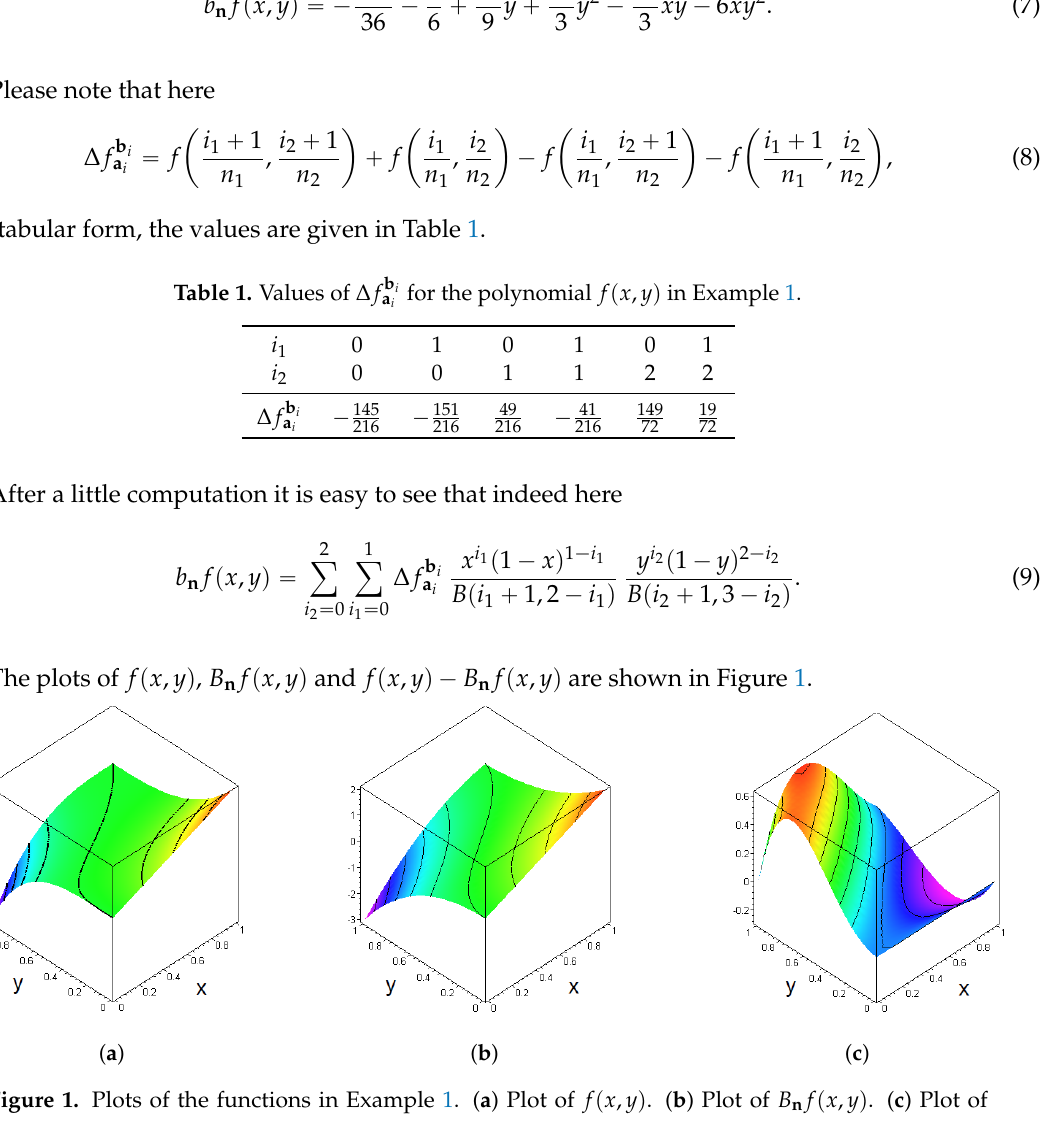
Figure 1. Plots of the functions in Example 1. ( a ) Plot of f f x , y B n f x , y p q ´ p q